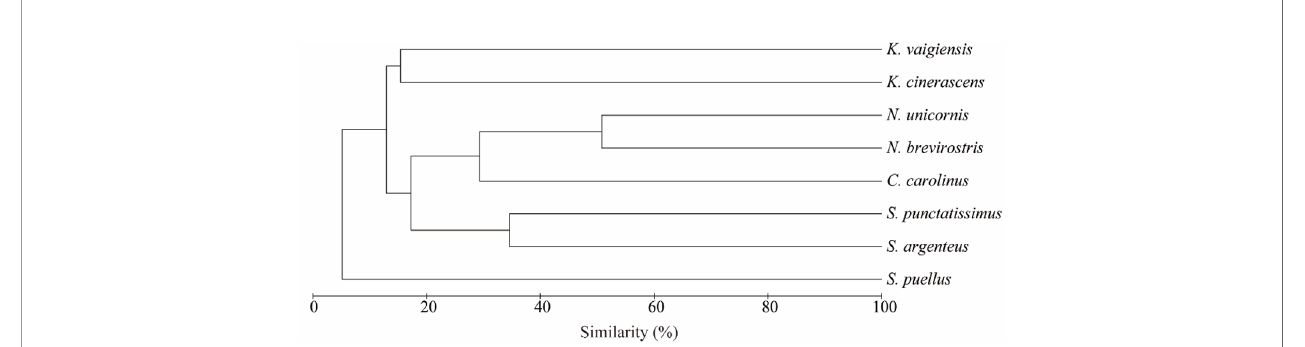
FIGURE 5 | Cluster analysis of macroalgae composition in intestines of eight fi sh from the Xisha Islands.